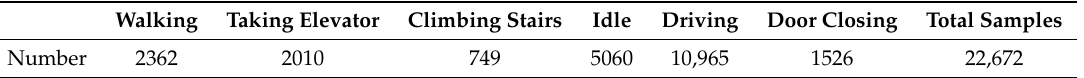
Table 4. Summary of samples for different activities.